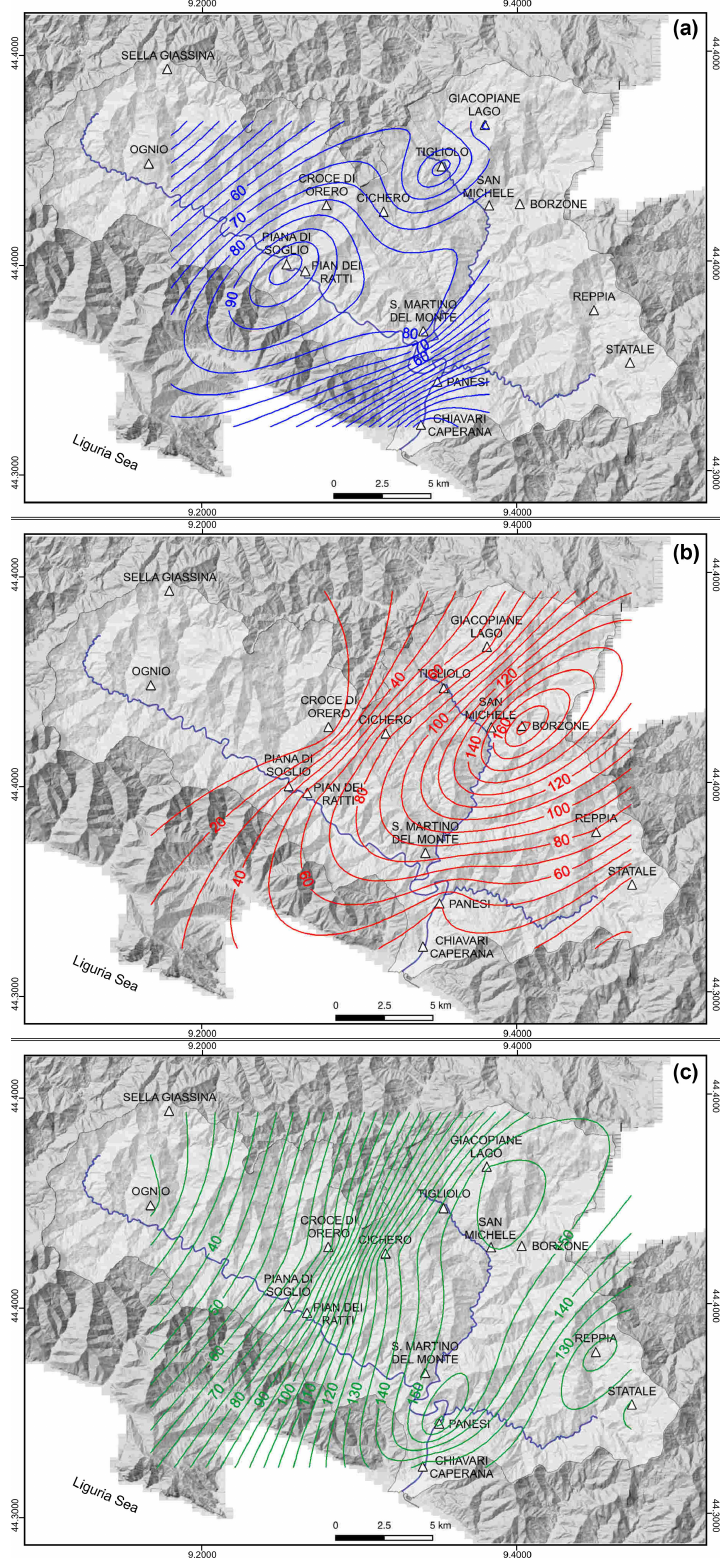
Figure 4. Spatial distribution of the cumulated event rainfall (mm) for the three rainfall events considered in the Entella catchment (Table 1). White triangles show location of the rain gauges used to prepare the maps, also shown in Fig. 1. Colored contour lines show